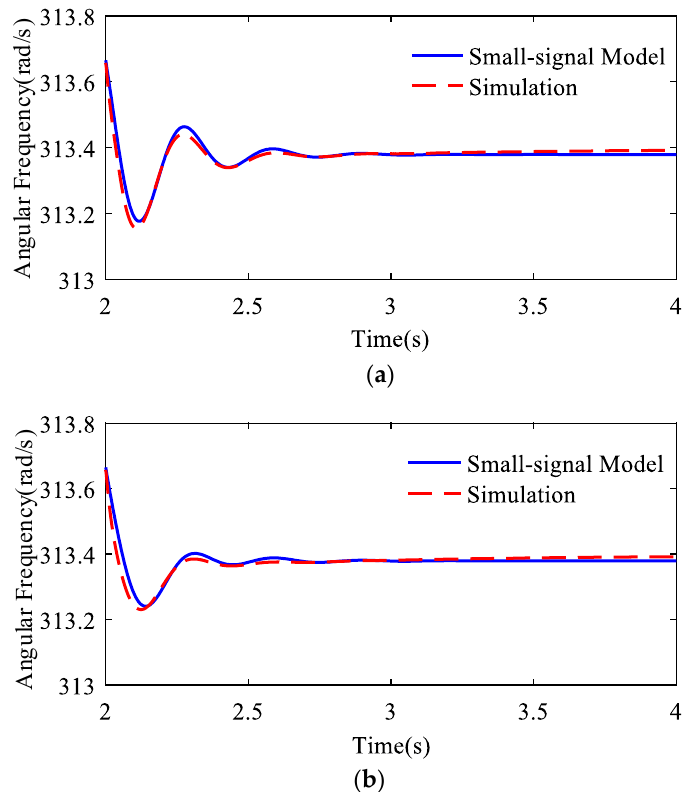
Figure 8. Step responses of SG angular frequency: ( a ) without the high-pass filter; ( b ) with the high-pass filter.